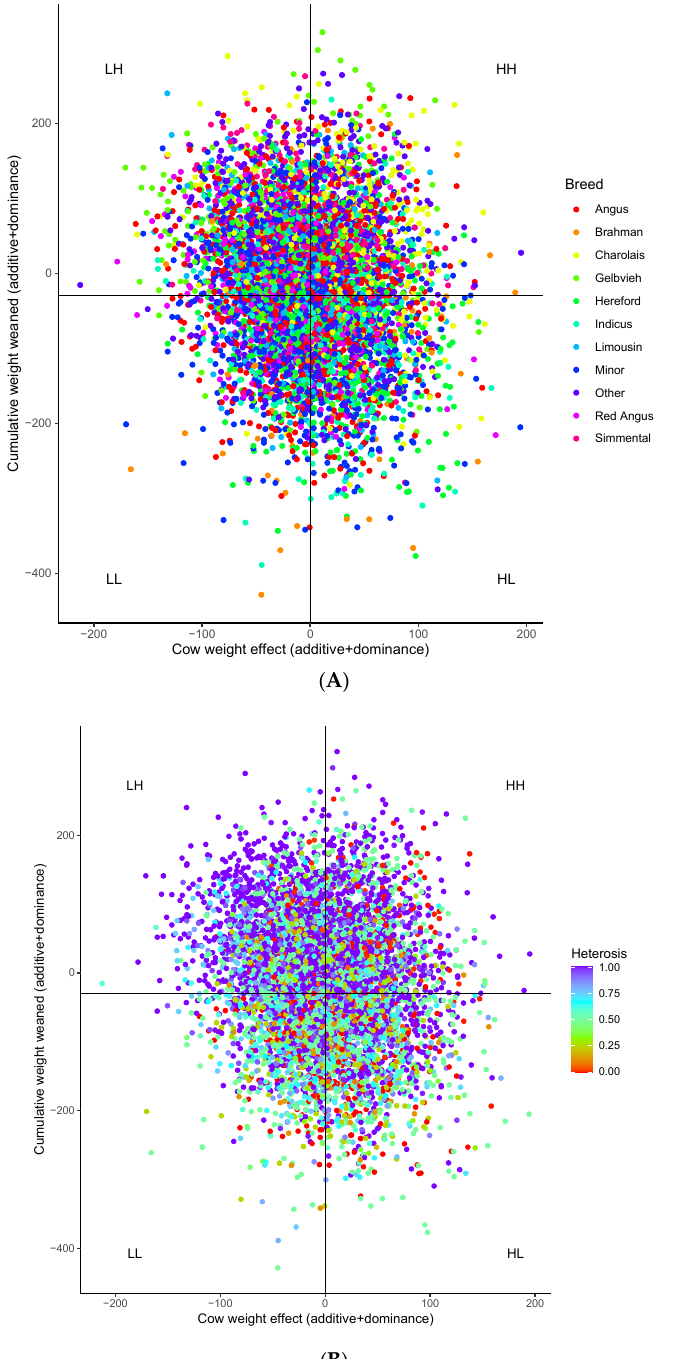
Figure 2. Total genetic effects (additive + dominance) of individual cows projected to eight-year-old cumulative weight weaned (WtW) and cow weight (CW). Each dot represents a single cow. The mean cow weight effect is shown by the vertical line, and the mean cumulative weight weaned effect by the horizontal line. Quadrants below and above the means for each trait are labeled: low CW/low WtW (LL), low CW/high WtW (LH), high CW/high WtW (HH), and high CW/low WtW (HL). Colors reflect breed composition ( A ) and level of heterosis ( B ). Individual breeds in A include cows who are at least 50% of one of the major breeds. Indicus includes cows that are at least 50% of one of the Bos indicus -influenced composites (Brangus, Beefmaster, Santa Gertudis). Minor combines cows that are at least 50% of a minor breed (Braunvieh, ChiAngus, Maine-Anjou, Salers, Shorthorn, South Devon, and Tarentaise), and Other are cows less than 50% of any single